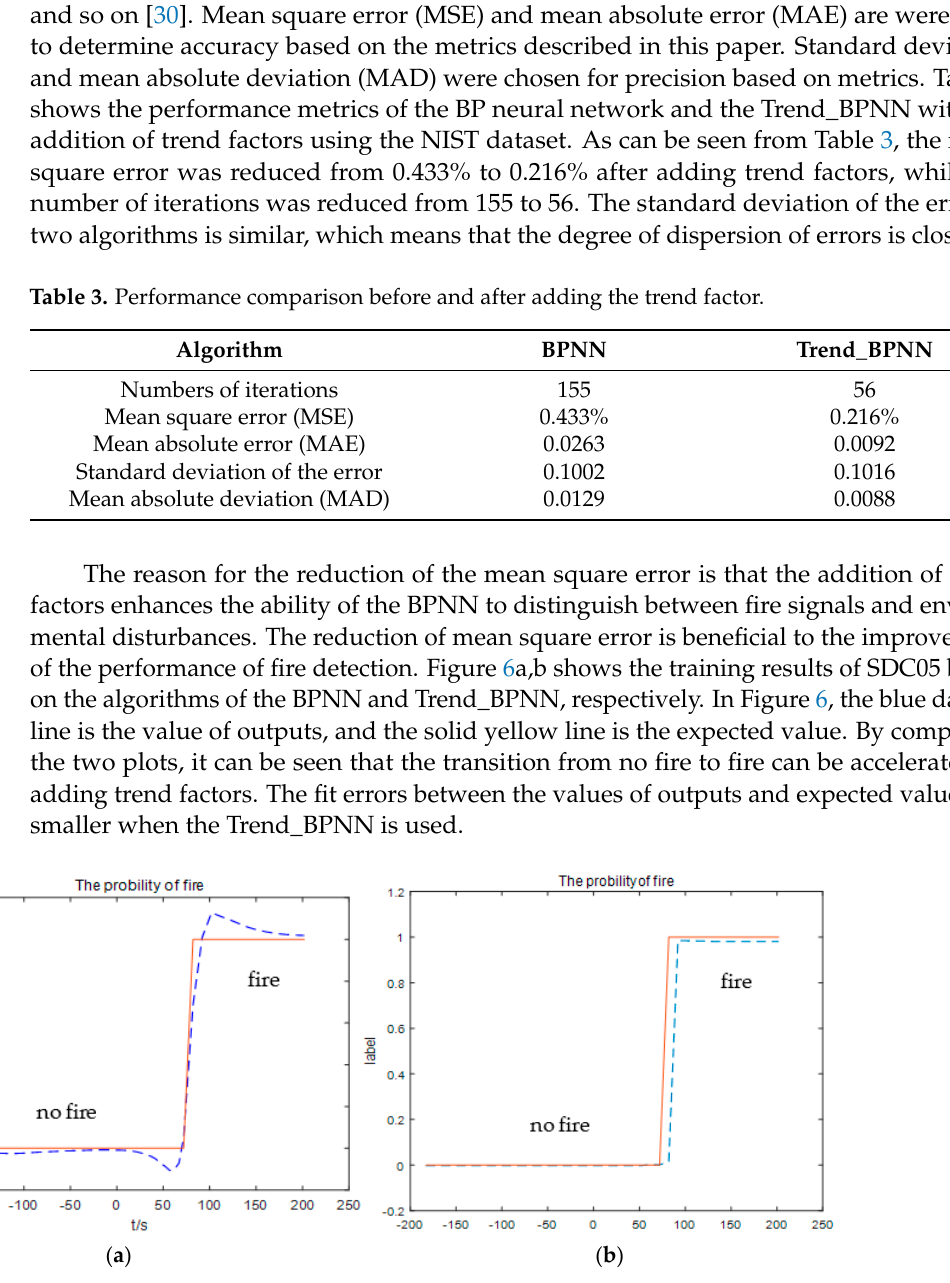
Figure 6. ( a ) Transition of fire warning based on BPNN; ( b ) transition of fire warning based on Trend_BPNN.